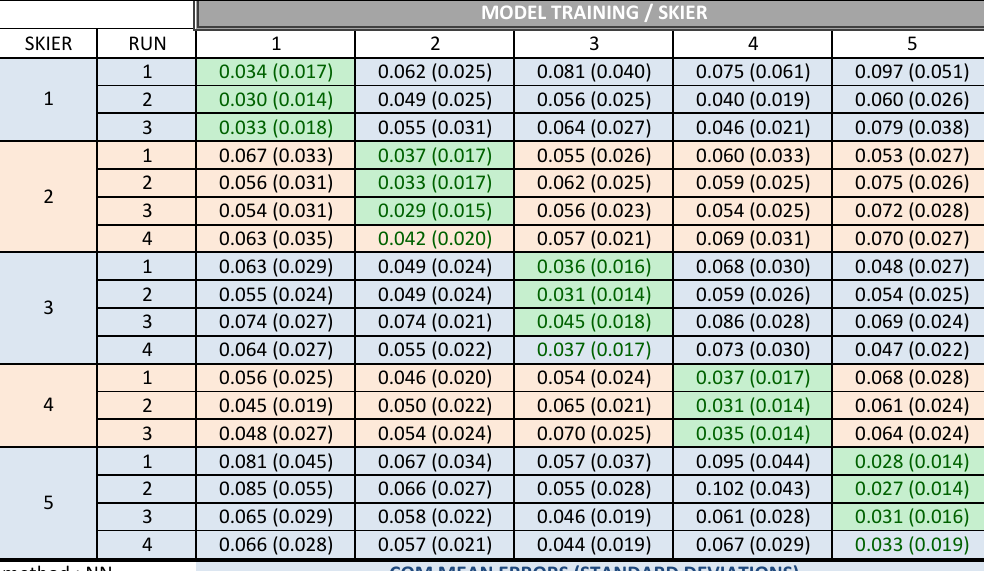
Table 1. Cross-validation of NN models. Models were learned using all runs of the same skier (columns). Mean errors and standard deviations of the COM position of these models were calculated for all 18 runs. All values in the table are given in m.